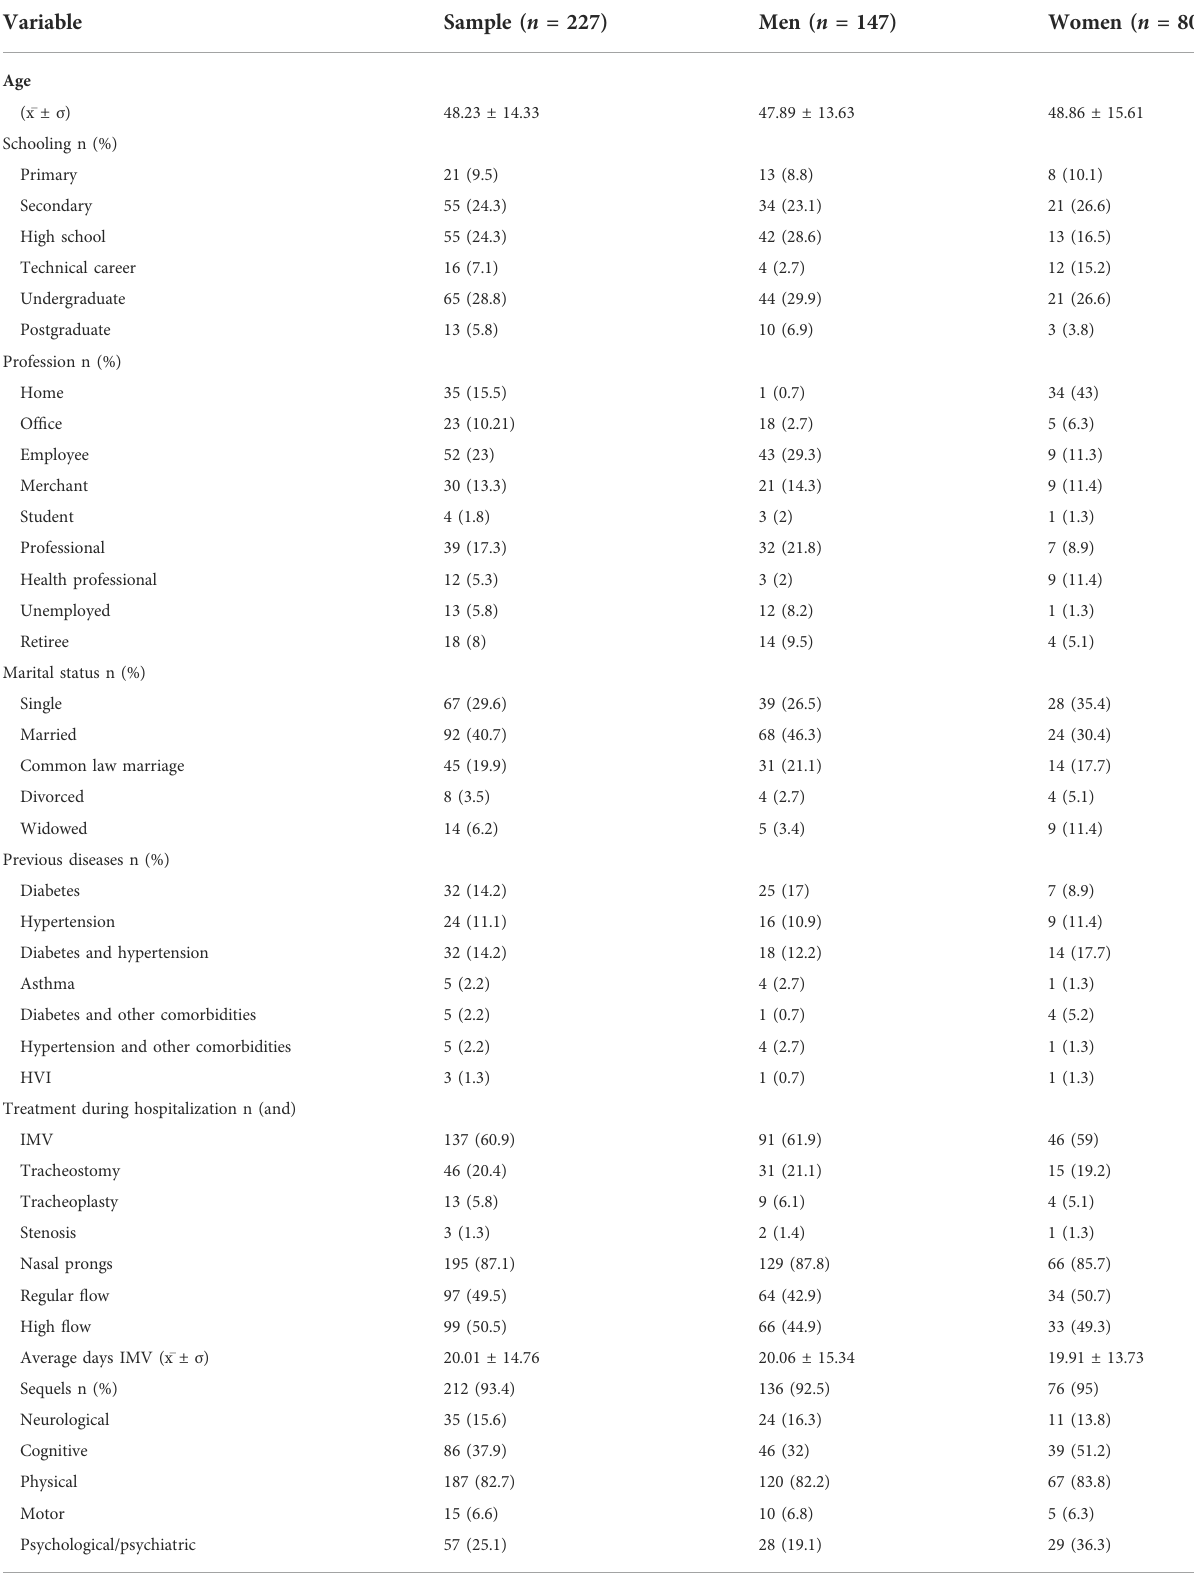
TABLE 2 Sociodemographic and clinical characteristics of surviving COVID-19